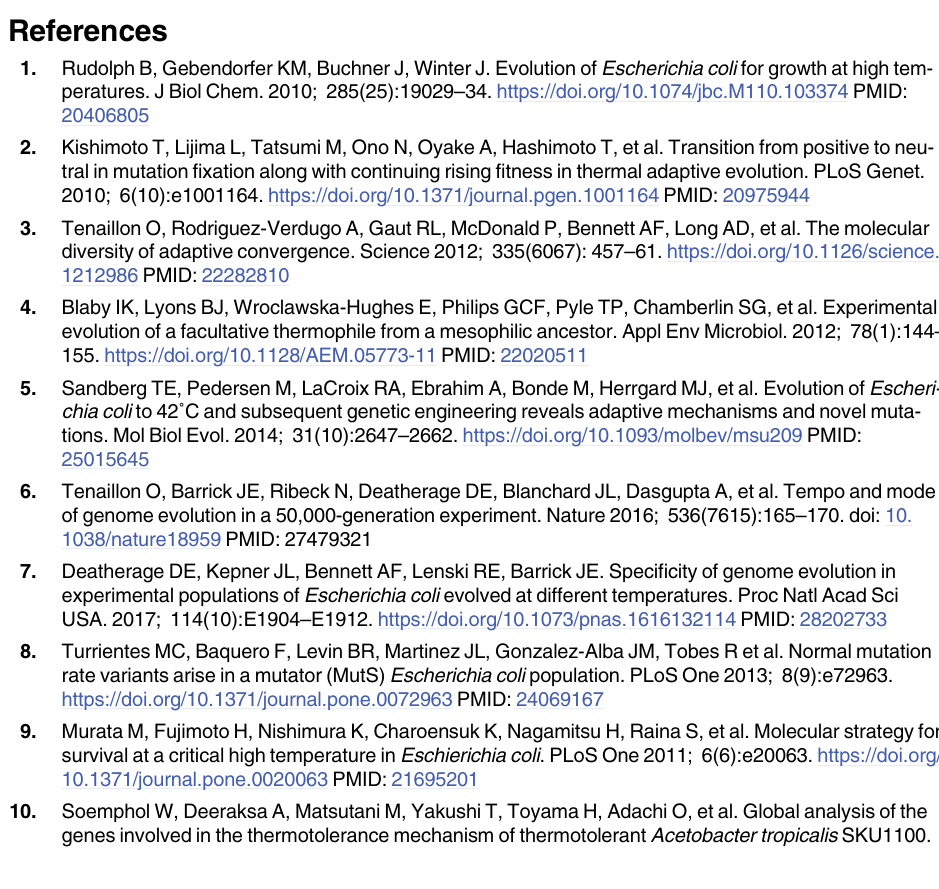
S8 Table. Primers used for confirmation of mutation sites in coding regions of thermoa- dapted mutants from E . coli